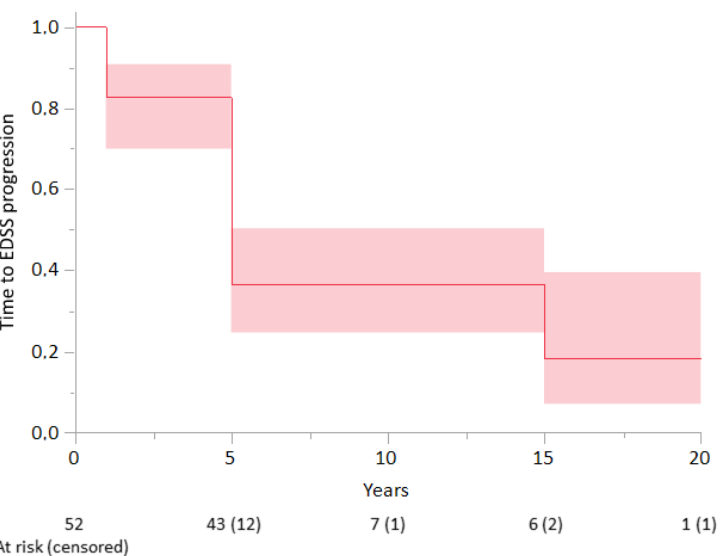
Figure 2. Time to Expanded Disability Status Scale (EDSS) score progression according to Kaplan– Meier analysis in the whole patient cohort ( n = 52). The shading represents 95% confidence intervals. No factors were identified as being significantly associated with neurological pro ‐ gression in both univariate and multivariate Cox analyses ( p > 0.05) (Table 3). However, a one ‐ unit (1 mg/kg) increase in cumulative cladribine dose was associated with a 7% re ‐ duction in the risk of progression (hazard ratio of 0.93 in multivariate analysis). Similarly, a trend for better outcomes was observed in women (47% hazard ratio increase in men compared to women). Nonetheless, the low number of patients within the subgroups lim ‐ its the power to detect the variables significantly associated with the TTP outcome. Table 3. Univariate and multivariate analyses of factors influencing time to EDSS score progression. Univariate Cox Regression Multivariate Cox Regression Variable HR (95% CI) p ‐ Value HR (95% CI) p ‐ Value Gender (male vs. female) 1.28 (0.62; 2.63) Disease duration to treatment initiation, years Cumulative s.c. cladribine dose, per 1 mg/kg body weight